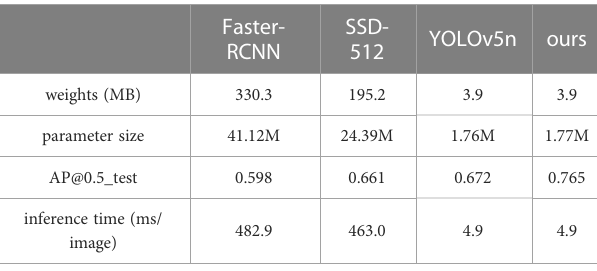
TABLE 4 The comparison results with other state-of-the-art